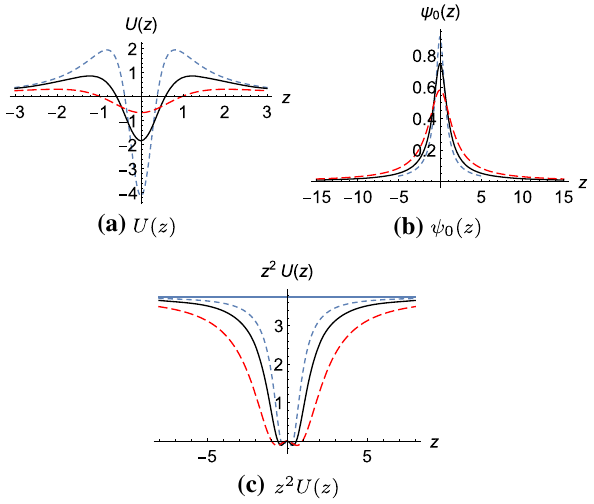
Fig. 3 Theshapesoftheeffectivepotential U ( z ) andthewavefunction of the graviton zero mode ψ 0 ( z ) for the second brane solution with n = 2. The parameters are set to κ = 1, c = 2 for blue short dashed lines, c = 3 for black lines, and c = 5 for red long dashed lines